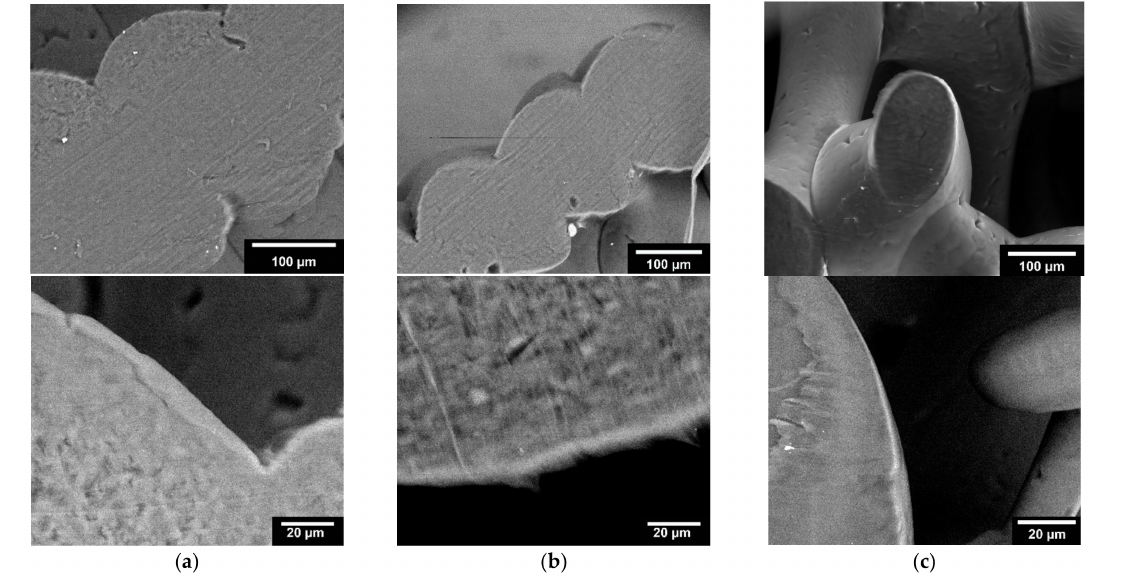
Figure 5. ESEM image of PCL scaffold: ( a ): honeycomb structure; ( b ): wave structure; ( c ): line structure; top: 800 × ; bottom: 2500 × magnification. Images were taken with an FEI Quanta 250 FEG, backscattered; acceleration voltage 10